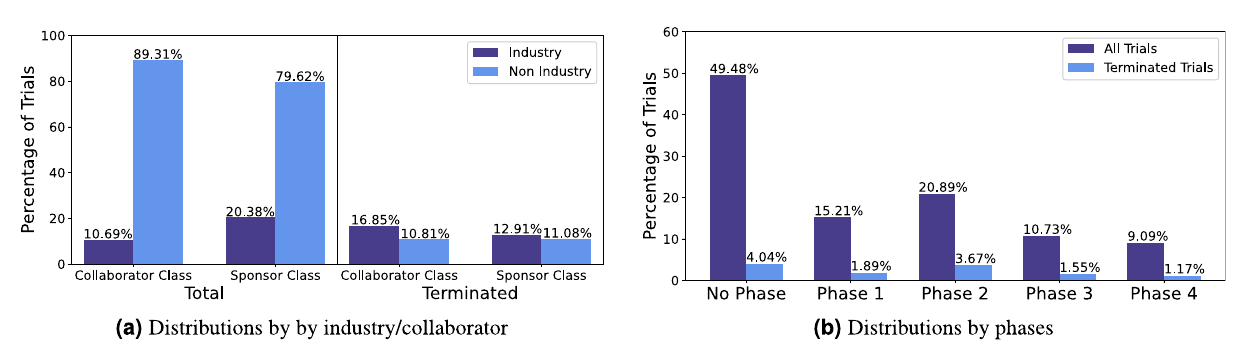
Figure 2. Distributions of clinical trials by collaborator and sponsor classes ( a ); and by trial phases ( b